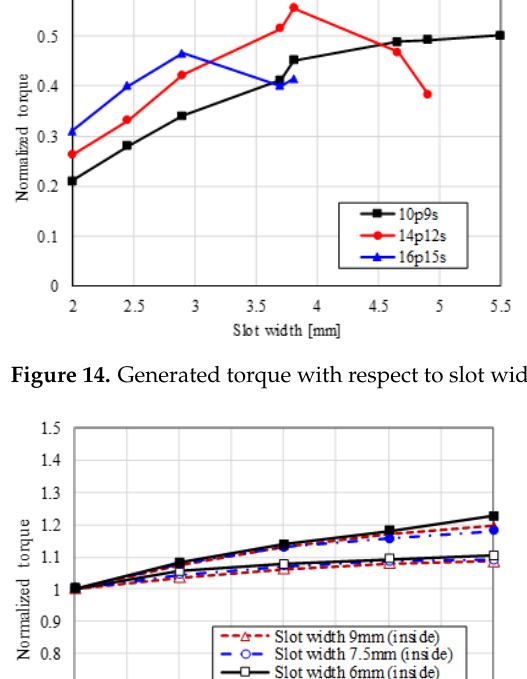
Figure 13. Generated torque due to the effect of the tooth cross-sectional area.